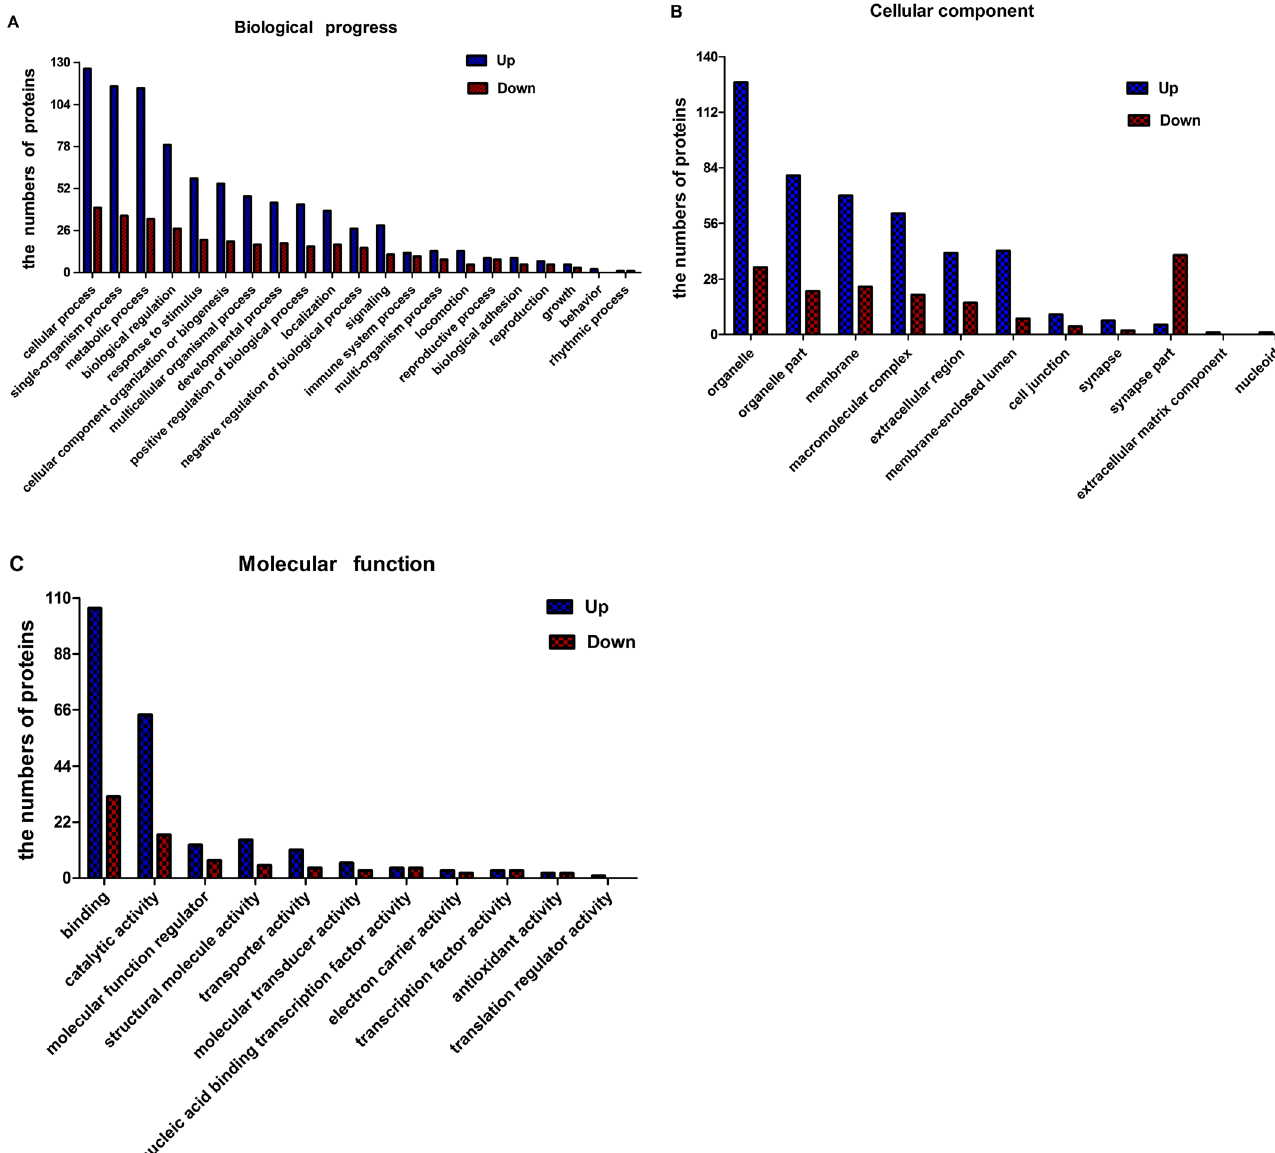
Figure 3. Gene ontology classi fi cation of up- and down- regulated proteins in BHK cells infected with Eimeria tenella . Blue bars indicate up- regulated proteins, red bars indicate down-regulated